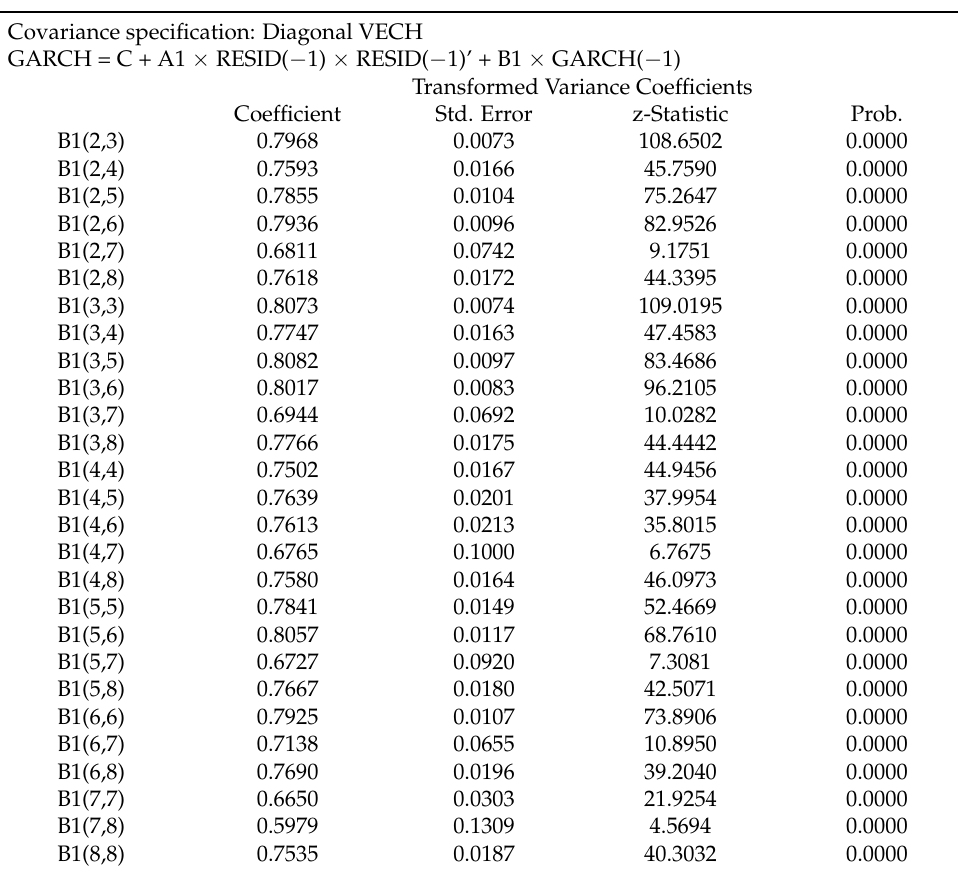
Table A1. Cont. Covariance specification: Diagonal VECH